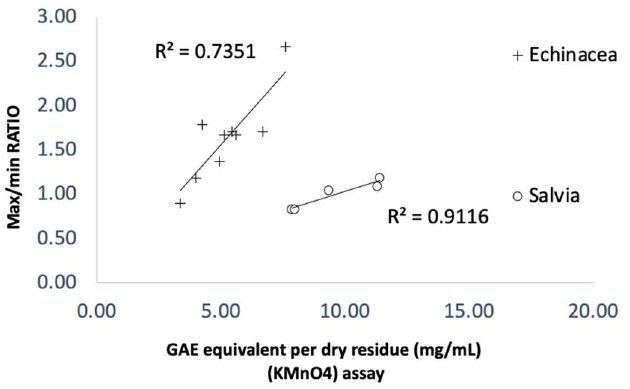
Figure 8. Scatterplot showing the linear correlation ( R 2 > 0.7) present between the two variables y = max/min ratio and x = GAE equivalent per dry residue (evaluated in the KMnO 4 assay) recorded in the comparative analysis of commercial mother tinctures.